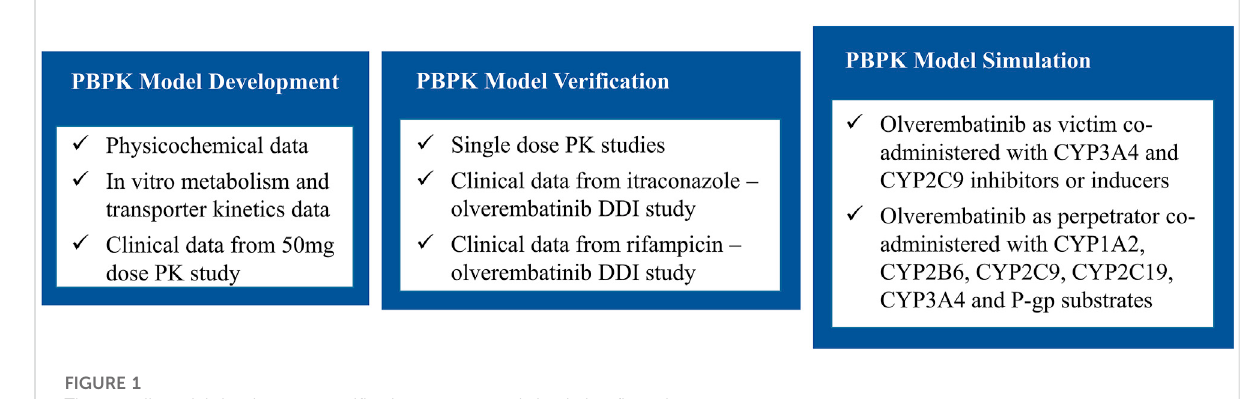
FIGURE 1 The overall model development, veri fi cation process, and simulation fl ow